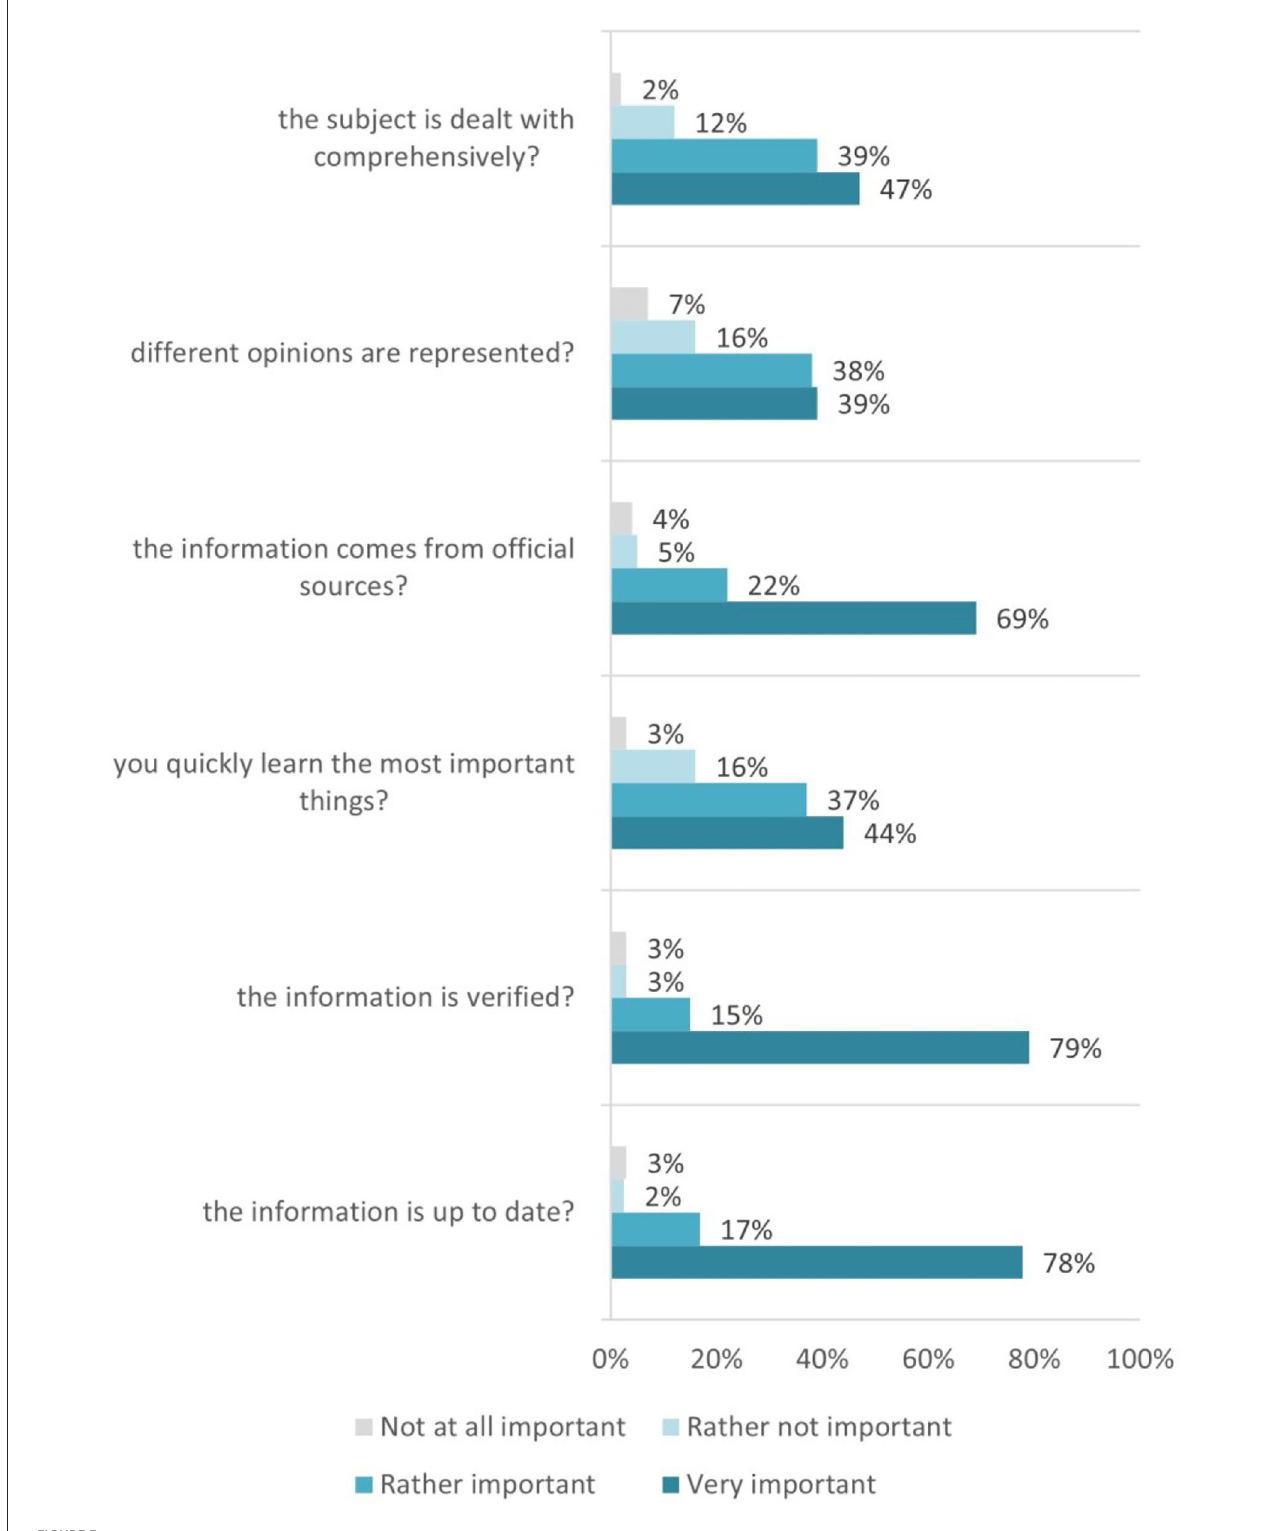
FIGURE3 Reached information evaluation/appraisal criteria used.